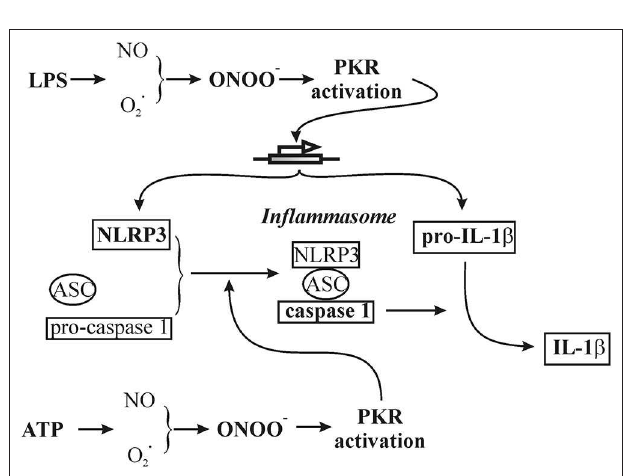
FIGURE 11 | Schematic of a working hypothesis of a role for the peroxynitrite/protein kinase R pathway in both LPS priming and subsequent ATP activation of the NLRP3 inflammasome in cardiac fibroblasts. The specific components addressed in the present study are in